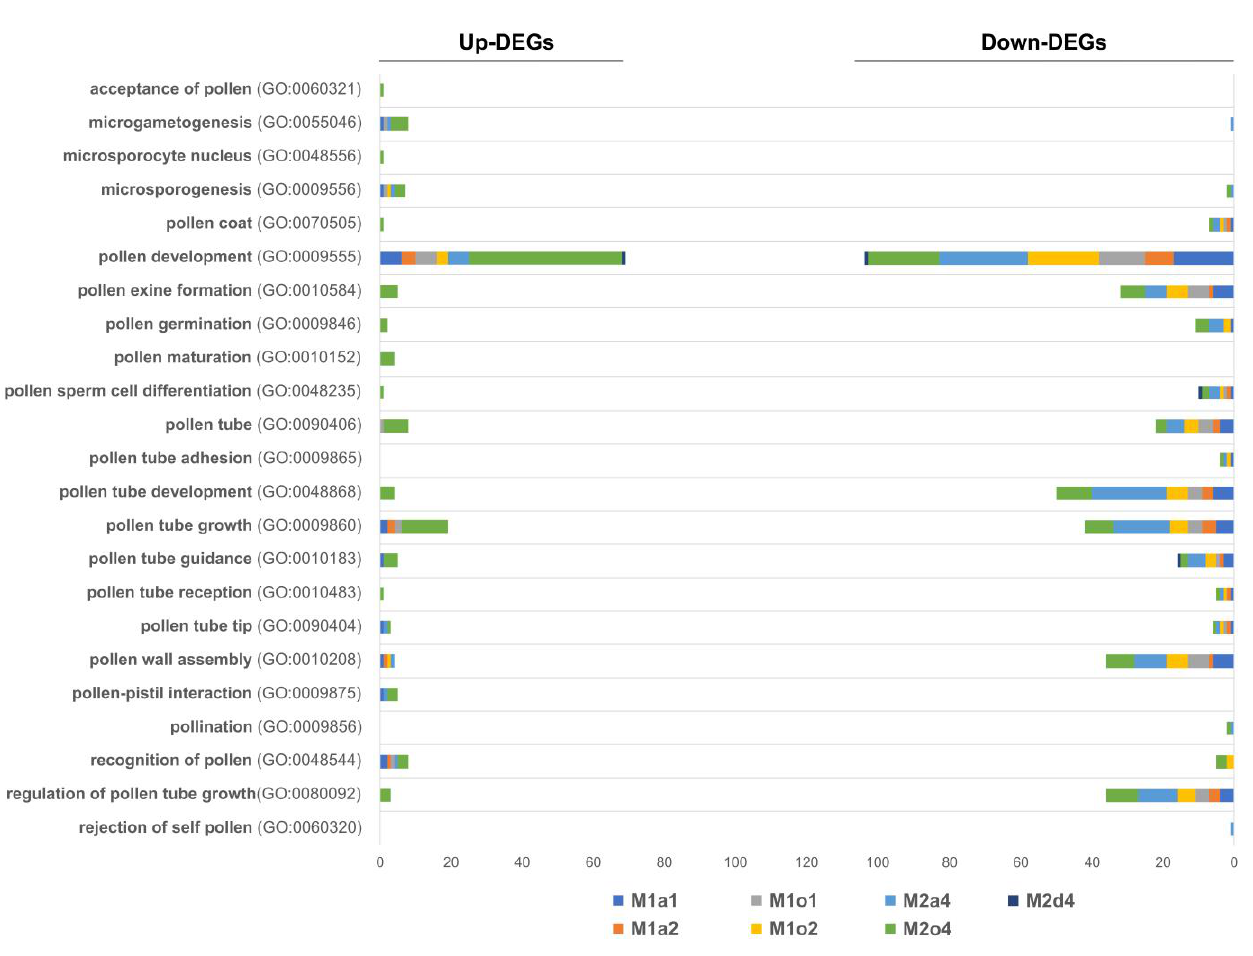
Figure 6. Regulation of up- and down-regulated differentially expressed genes (DEGs) in ovules in stages S1 (1), S2 (2), and S3/S4 (4) from apomictic L. multiflorum (M), sexual L auriculifolium (a) and L. ovalifolium (o), and facultative apomictic L. dodartii (d), annotated with Gene Ontology (GO) terms related to pollen. DEGs represent the number of significant genes found to be differently expressed in each comparison. Table 6. Changes in expression of uniquely annotated differentially expressed genes (DEGs) related to pollen from ovules of apomictic L. multiflorum (M) in S1 (1) relative to sexual L. auriculifolium (a) and L. ovalifolium (o) in either S1 (1) or S2 (2), and L. multiflorum (M) in S2 (2) relative to L. auriculifolium (a), L. ovalifolium (o), and facultative apomictic L. dodartii (d) in S3/S4 (4). Annotated DEGs according to A. thaliana homologs (gene names) were searched in biological process (BP), molecular function (MF), and cellular component (CC) Gene Ontology (GO) terms related to pollen (red: up-regulated DEGs; blue: down-regulated